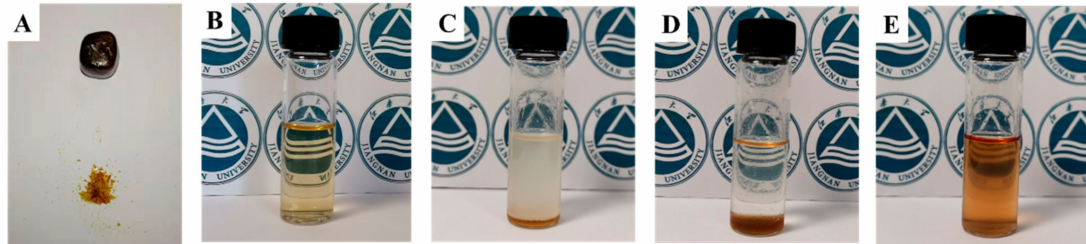
Figure 1. ( A ) The apparent picture of poly(DHHCA- co -LA). Dissolving state in ( B ) acetone at saturation, ( C ) deionized water after standing for 10 min, ( D ) 1M HCl aqueous solution, ( E ) 1M NaOH aqueous solution.